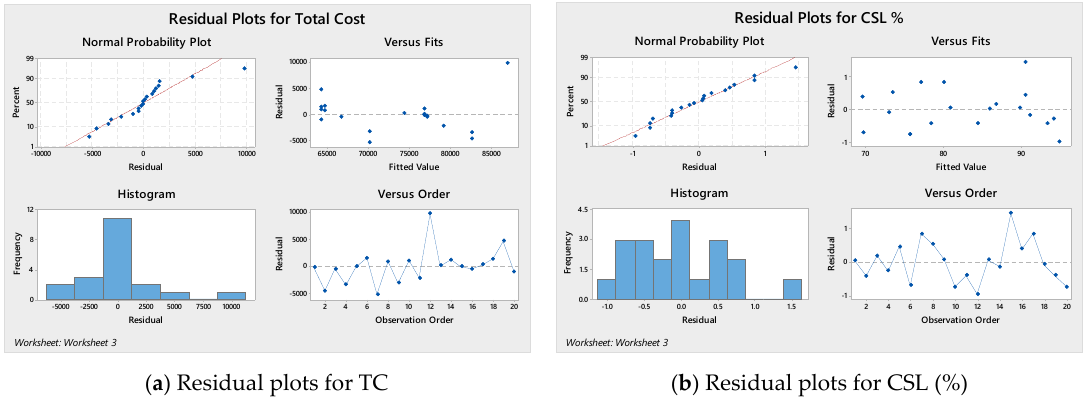
Figure 12. CCD—residual plots for TC and CSL.